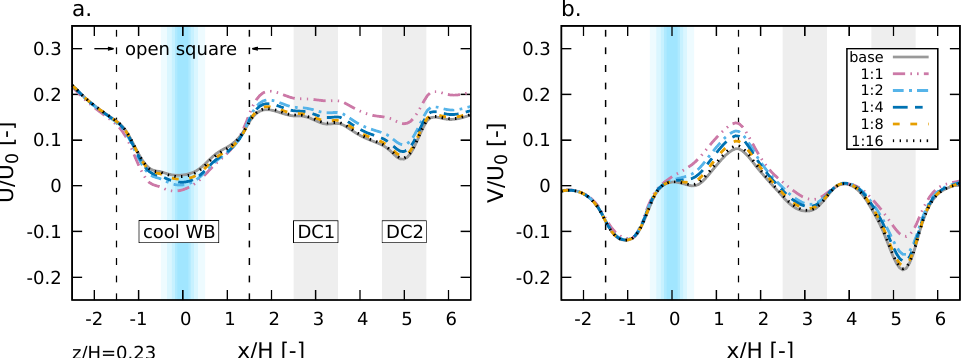
Figure 9. Profiles of ( a ) normalised streamwise ( U / U 0 ) and ( b ) normalised spanwise ( V / U 0 ) velocity over a horizontal line in the middle of the street canyon ( y / H = 1) at pedestrian level ( z / H = 0.23) for the cool water body cases ( ∆ T = − 2 K) and different water body sizes. The shaded areas denote the position of the water body (blue) and the downwind canyons DC1 and DC2 (grey). The location of the open square is shown with the vertical dotted